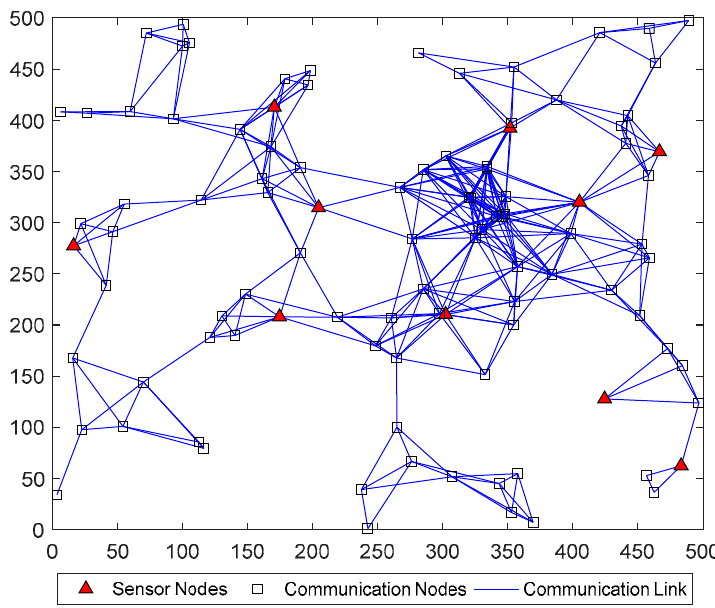
Figure 13. A large-scale sparse sensor network with 100 nodes.